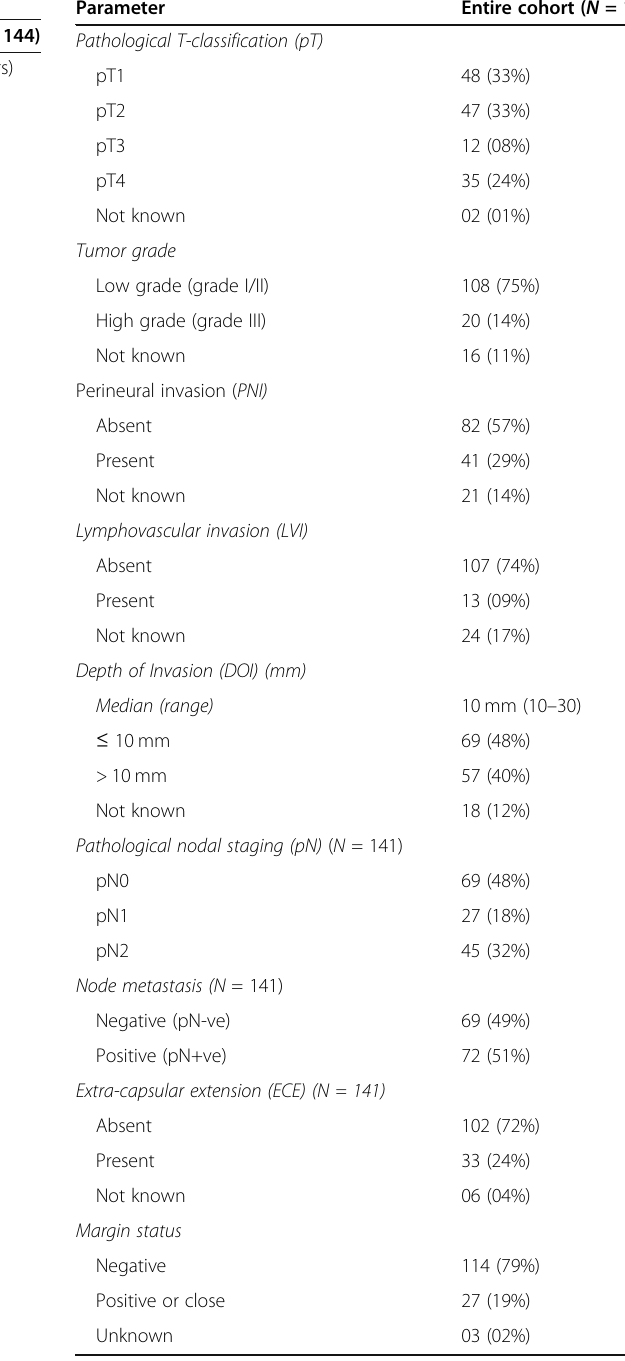
Table 1 Demographic details and treatment characteristics